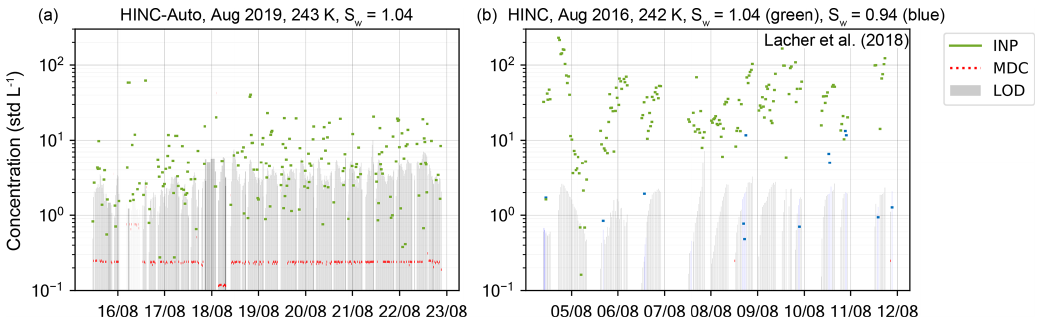
Figure 12. INP measurements at the JFJ over a period of 7d with (a) HINC-Auto at T = 243K and S w = 1 . 04 and (b) HINC at T = 242K and S w = 1 . 04 (green markers) or S w = 0.94 (blue markers) (see Lacher et al., 2018). Green and blue markers indicate the ambient INP concentration; the grey bar indicates the limit of detection (LOD) with a 62.3% (1 σ ) confidence interval; red markers indicate measured INP concentrations below the minimum detectable concentration (MDC, one count during the sampling time). Every grey bar with a correspond- ing green, blue or red dot represents one